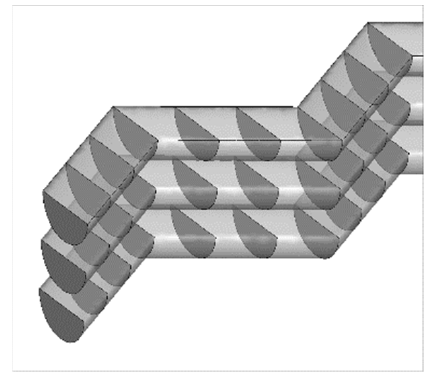
Figure 8. Sectional design diagram.